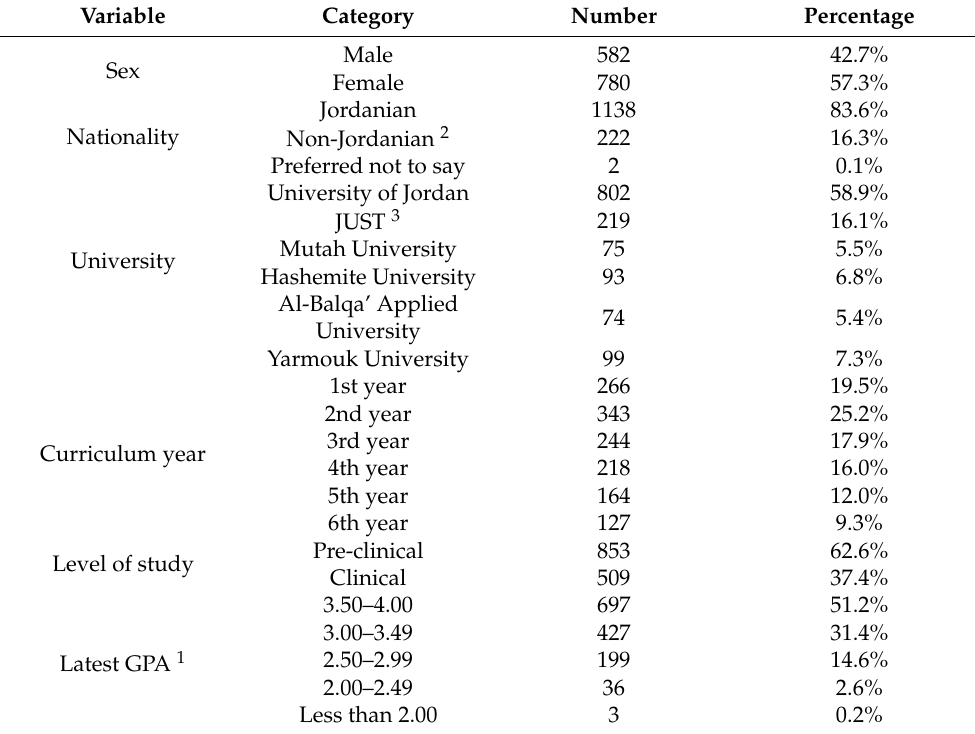
Table 1. Characteristics of the study